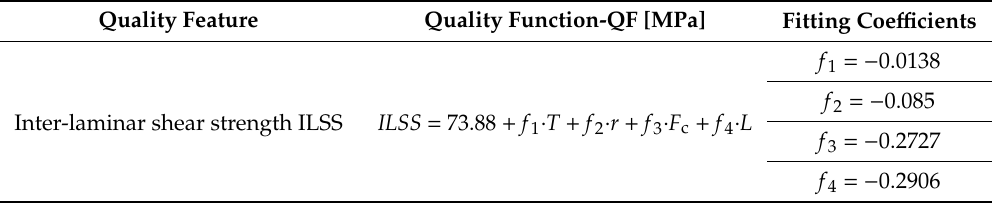
Table 4. The Quality Function (QF) derived for the AFP